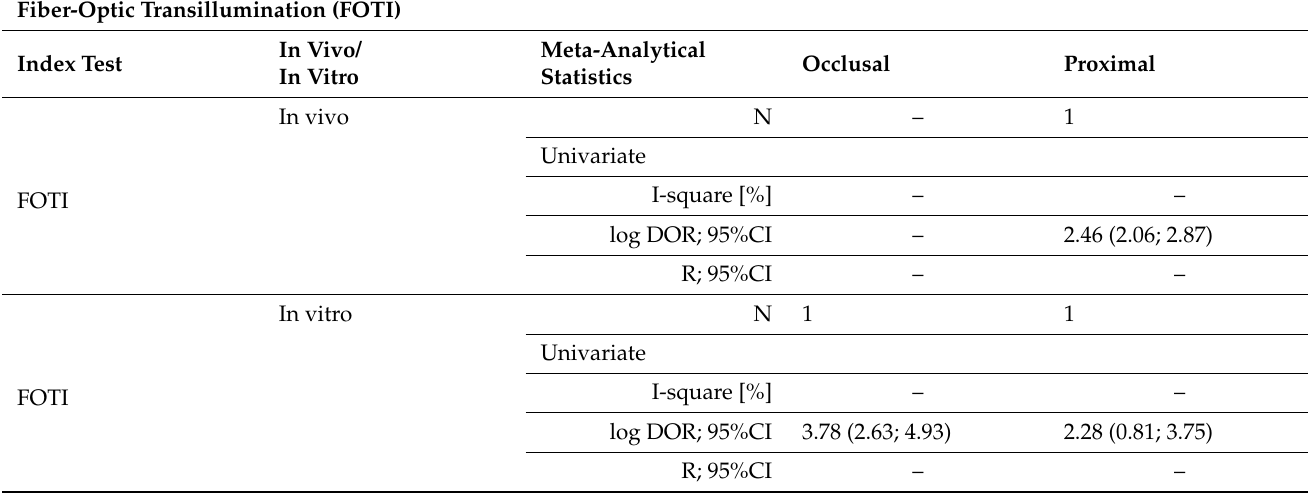
Table 8. Meta-analytical results for the fibre-optic transillumination (FOTI) test. Only descriptive